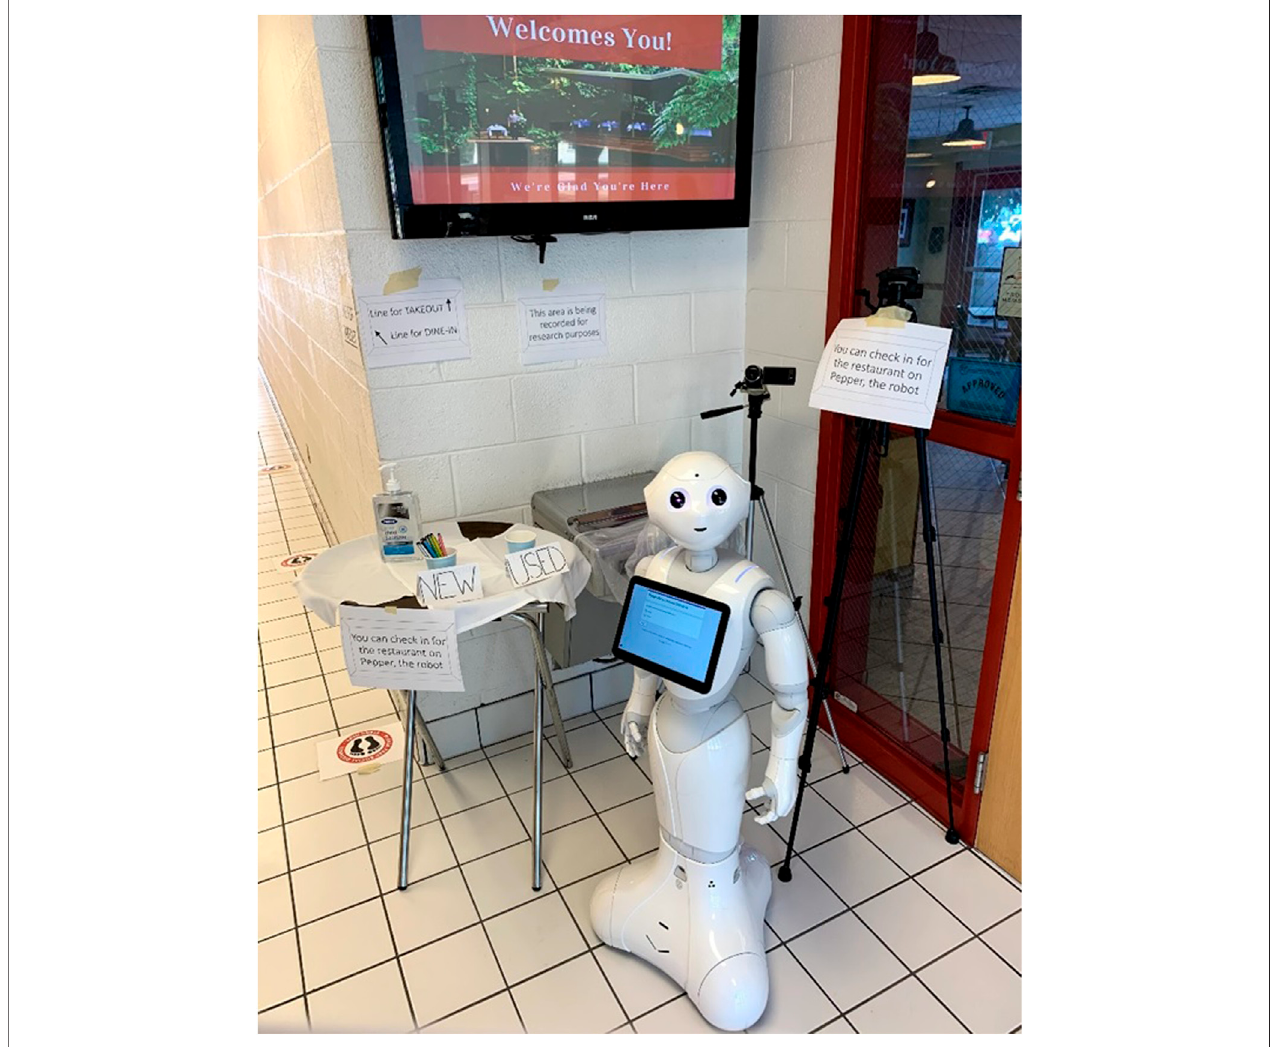
FIGURE 4 | Pepper acting as a greeter at the 100 W.